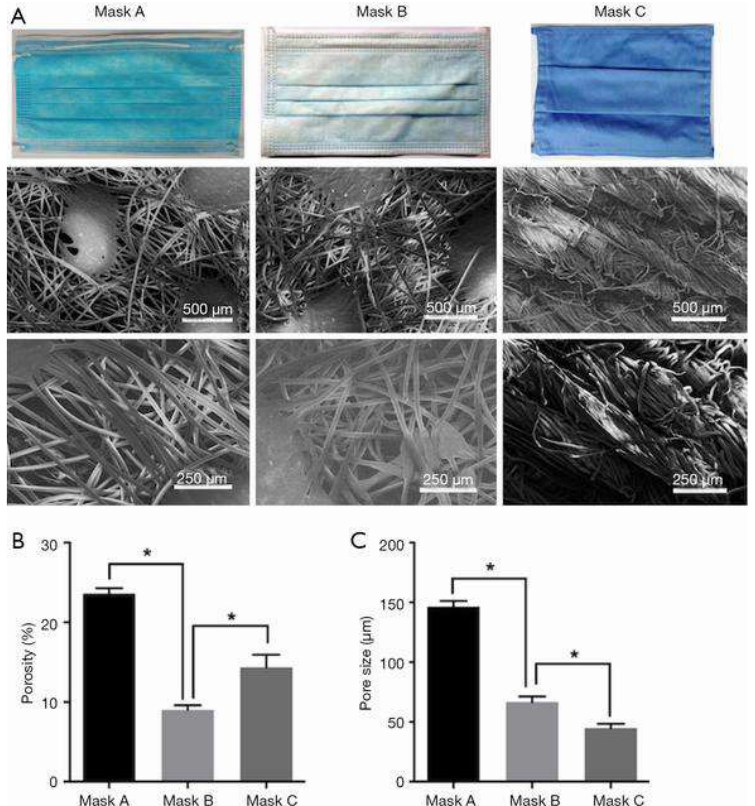
Figure 5. ( A ) SEM images showing the fibre structure of different masks. ( B ) Mask porosity. ( C ) Mask void size distribution. Reproduced with permission from reference [58]. Copyright (2019), Ann Tans Medicine.